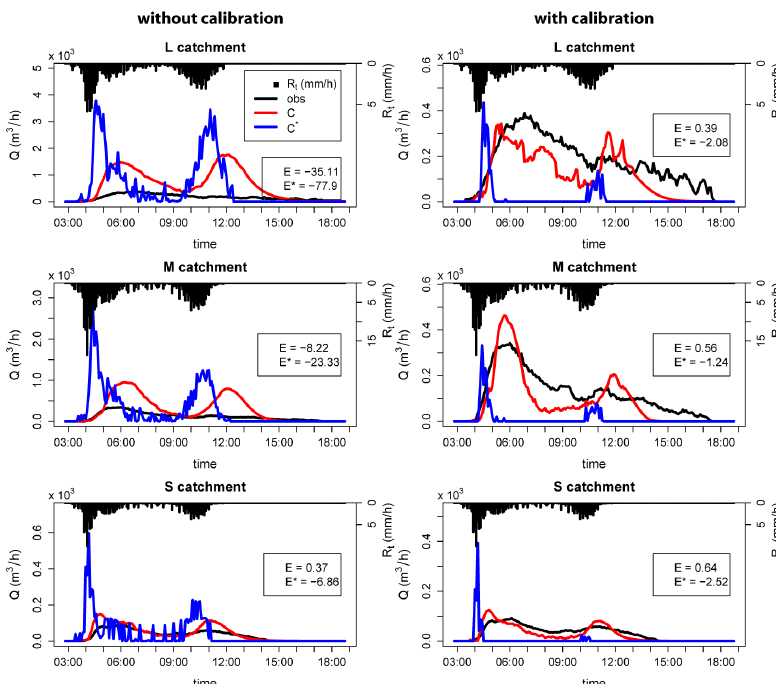
Fig. A1. Hydrographs ( Q , m 3 h − 1 ) modelled using the closure relation C (red) and C ∗ (blue), compared with the observed discharge (obs, black), for an event on 1 April 2010. Rainfall intensity ( R t , mmh − 1 ) is shown on the secondary axis. E and E ∗ are the Nash–Sutcliffe indexes for the closure relation C and C ∗ , respectively. Left panels, without calibration; right panels, with calibration.